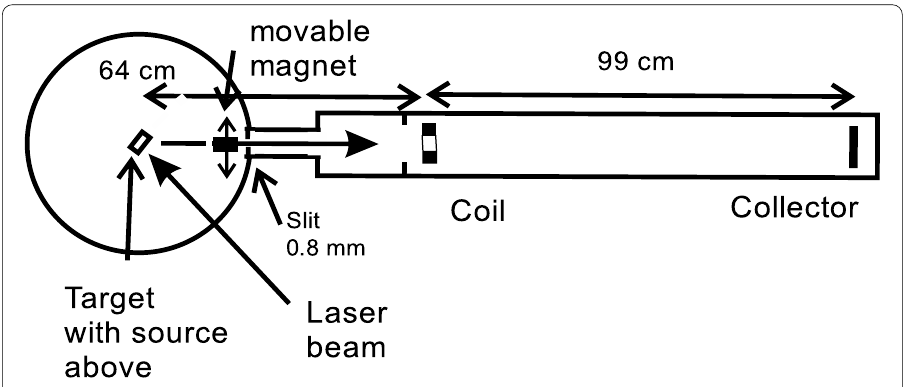
Fig. 1 Horizontal cut through the apparatus. The coil—collector part direction is at 45º relative to the incoming laser